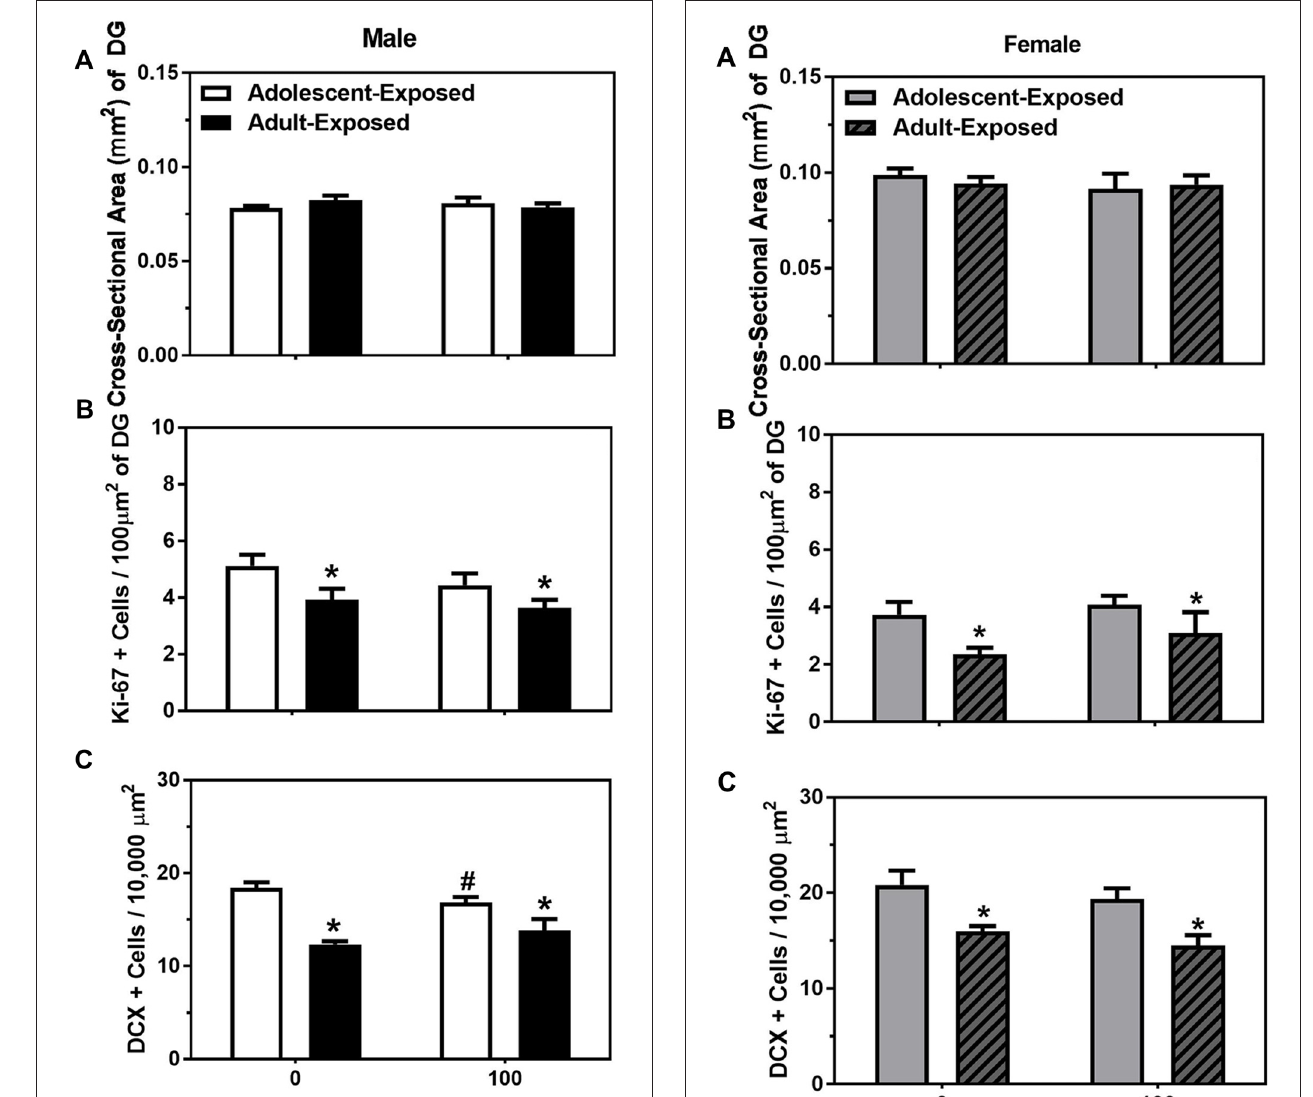
of DCX-positive cells in the female dentate